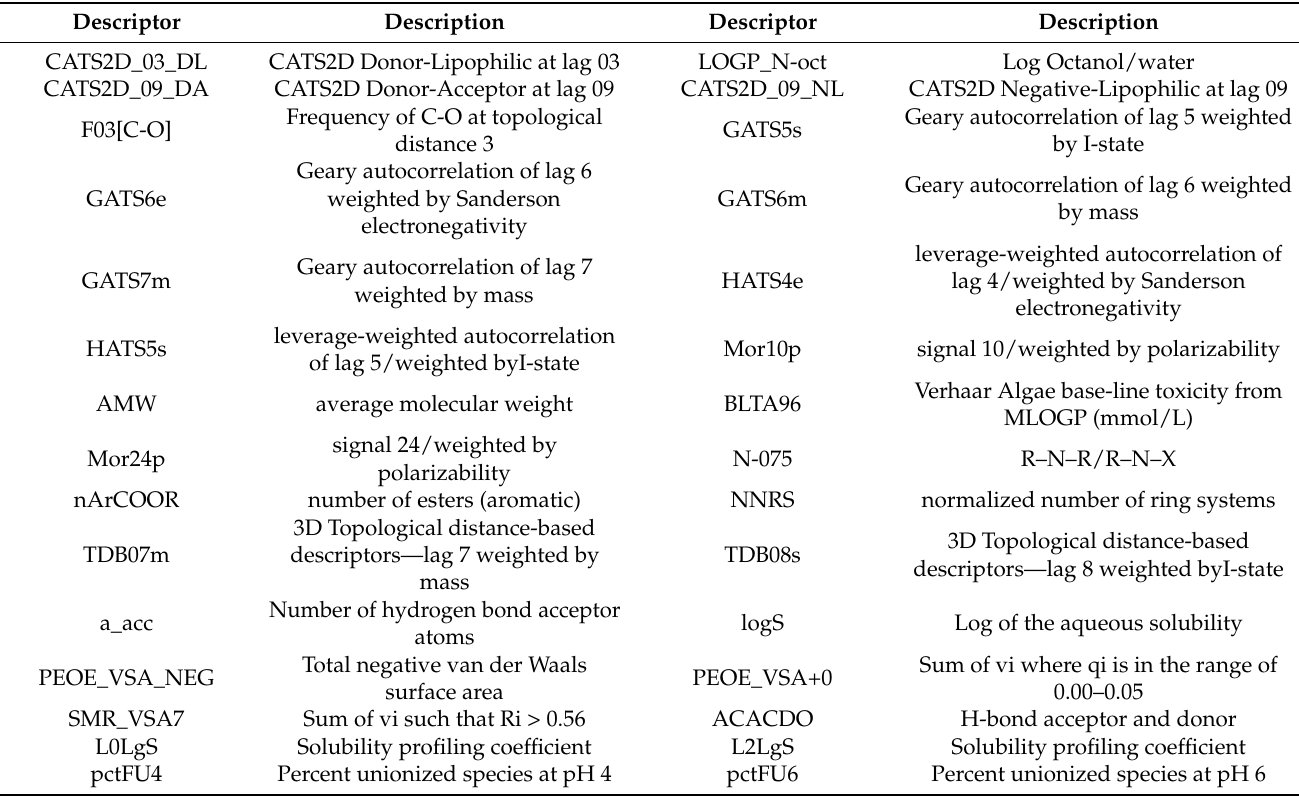
Table 1. List of the 30 Most Frequently Selected Descriptors by Evolutionary